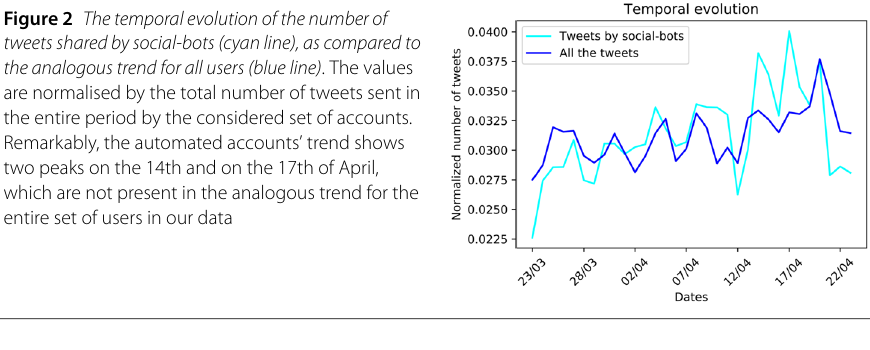
Figure 2 Thetemporalevolutionofthenumberof tweetssharedbysocial-bots(cyanline),ascomparedto theanalogoustrendforallusers(blueline) . The values are normalised by the total number of tweets sent